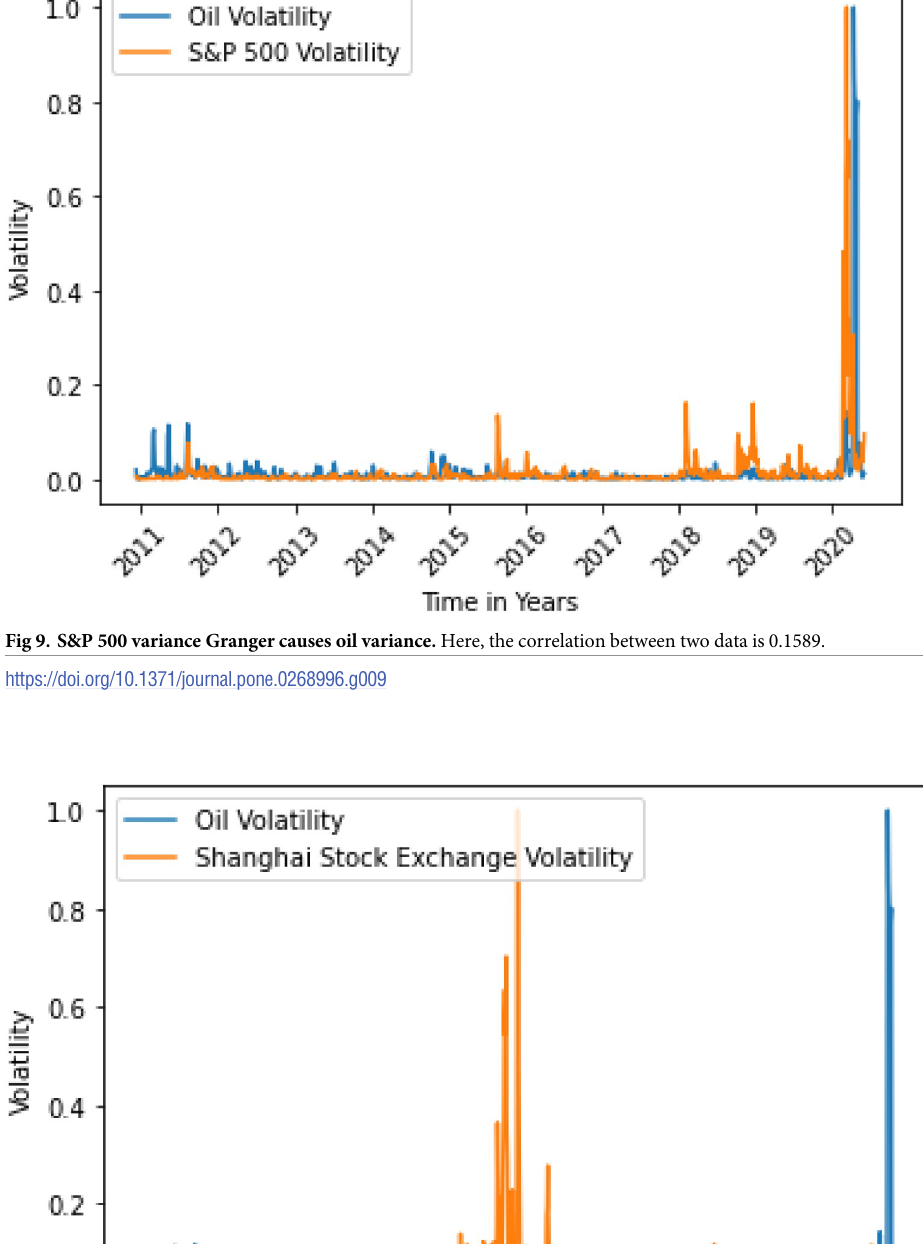
PLOS ONE | https://doi.org/10.1371/journal.pone.0268996 March 9, 2023 18 /